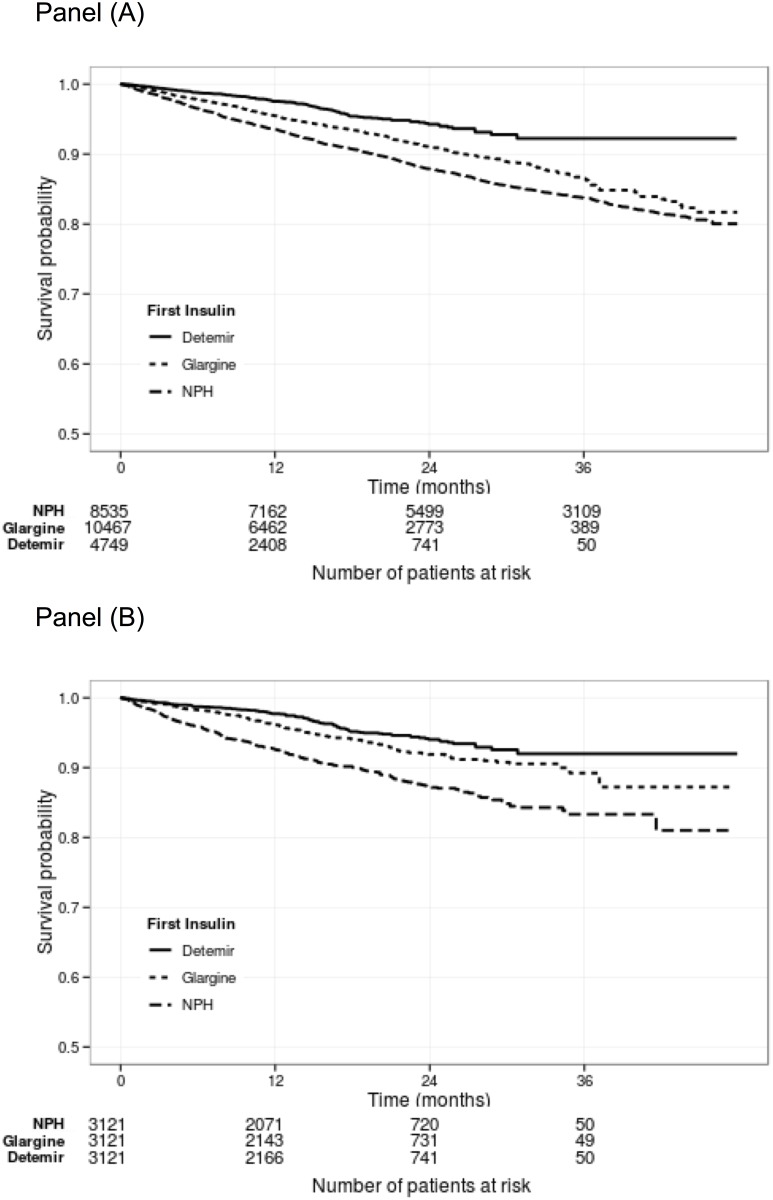
Kaplan-Meier survival curves for the initializers of the three basal insulins, Panel (A): unmatched cohort (n = 23 751), Panel (B): propensity score matched cohort (n = 9363), Log-rank p-values<0.001 for detemir vs. NPH, and glargine vs. NPH in both panels.Log-rank p-value for detemir vs. glargine <0.001 in Panel (A) and 0.005 in Panel (B).